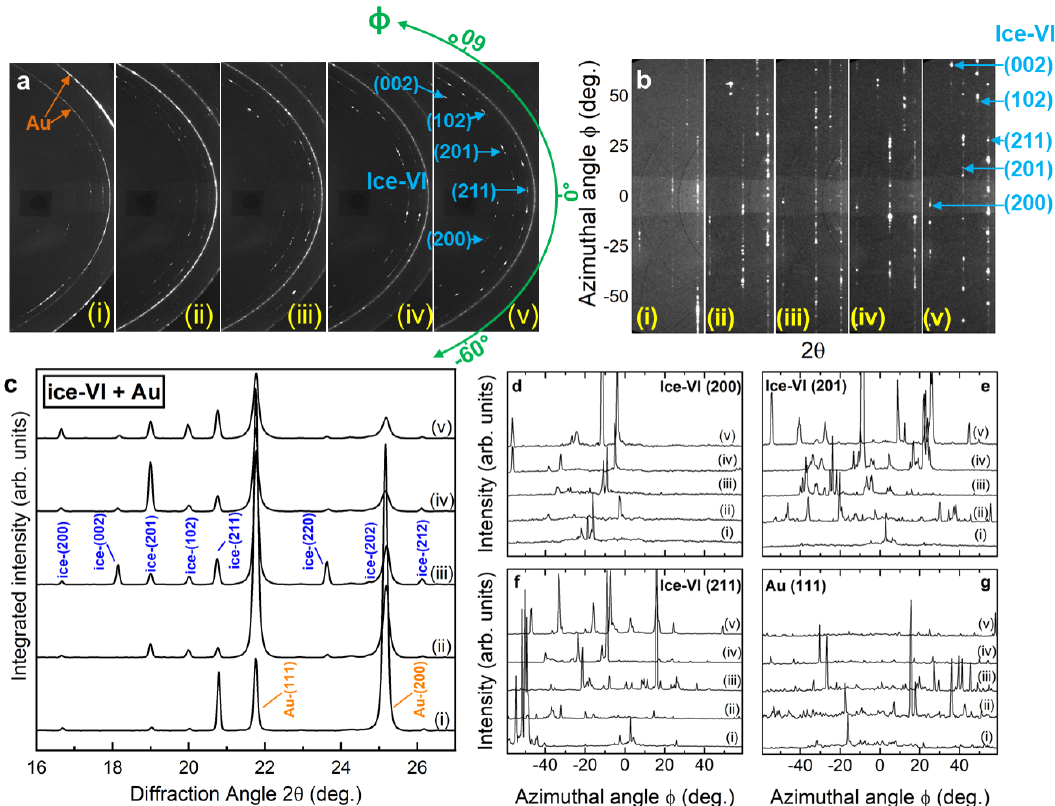
Fig. 4 In situ X-ray diffraction collected at PAL-XFEL during irradiation of sample #3 with 5 X-ray pulses at 30 Hz. The beam was attenuated to 50% of the full X-ray fl uence. Diffraction was collected from each individual X-ray pulse, as indicated by labels (i) – (v). The sample pressure was 2 GPa, where H 2 O adopts the ice-VI structure. a Original and b unrolled diffraction images, and c integrated diffraction patterns. d – f Azimuthal intensity variations of the (200), (201), and (211) ice-VI re fl ections, respectively. g Azimuthal intensity variations for the (111) Au re fl ection. Signi fi cant changes in the azimuthal intensity distribution of both the Au and ice-VI re fl ections are consistent with melting and recrystallization of the H 2 O sample between subsequent X-ray